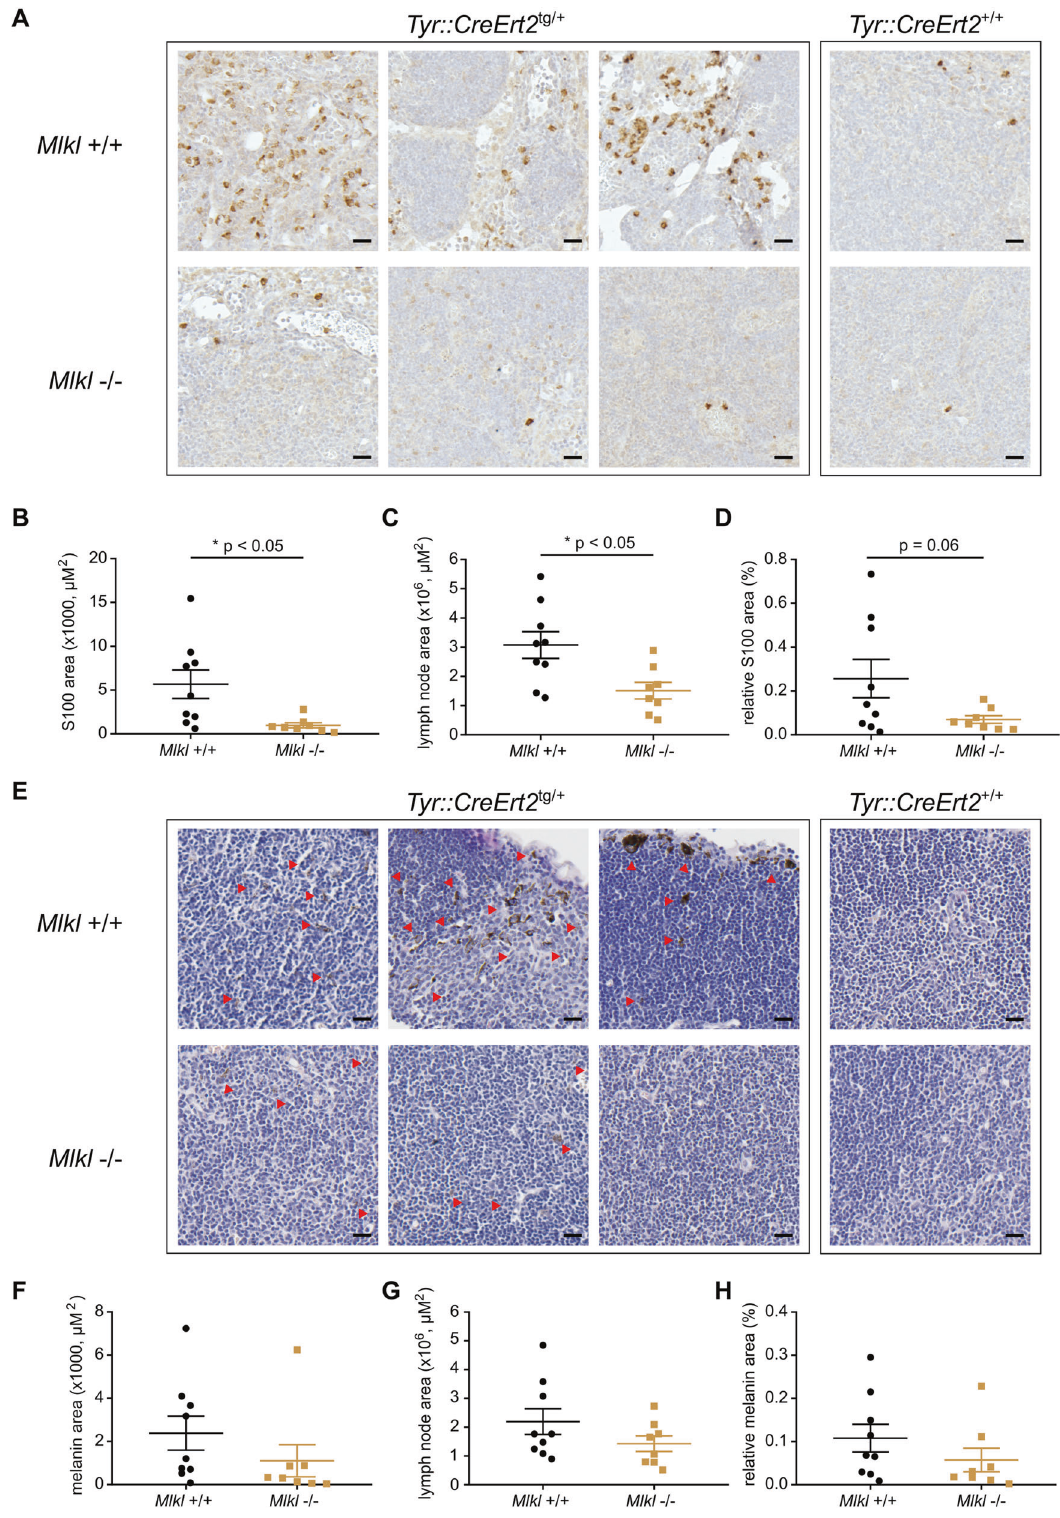
Fig. 4 MLKL de fi ciency in Braf V600E Pten − / − melanoma delays colonization of melanoma cells in the lymph node of male mice. Histology and quanti fi cation of S100 staining ( A – D ) and melanin ( E – H ) in lymph node tissue collected at day 36 after 4-OHT treatment. Three representative lymph node sections are shown for each genotype with Tyr::CreERT2 + / + or tg/ + ;Braf V600Etg/ + ;Pten fl / fl background. Images were taken with a Slide Scanner Axio Scan (Zeiss) and analyzed using ZEN (blue) software (Zeiss). Scale bar represents 20 µM. After removal of outliers (removal if value is higher/lower than 2 x SEM), unpaired two-tailed t -test was performed for S100/melanin area ( B , F ), lymph node area ( C , G ), and relative S100/melanin area (S100/melanin area divided by lymph node area) ( D , H ). Red arrows indicate melanin-pigmented cells. * p < 0.05.